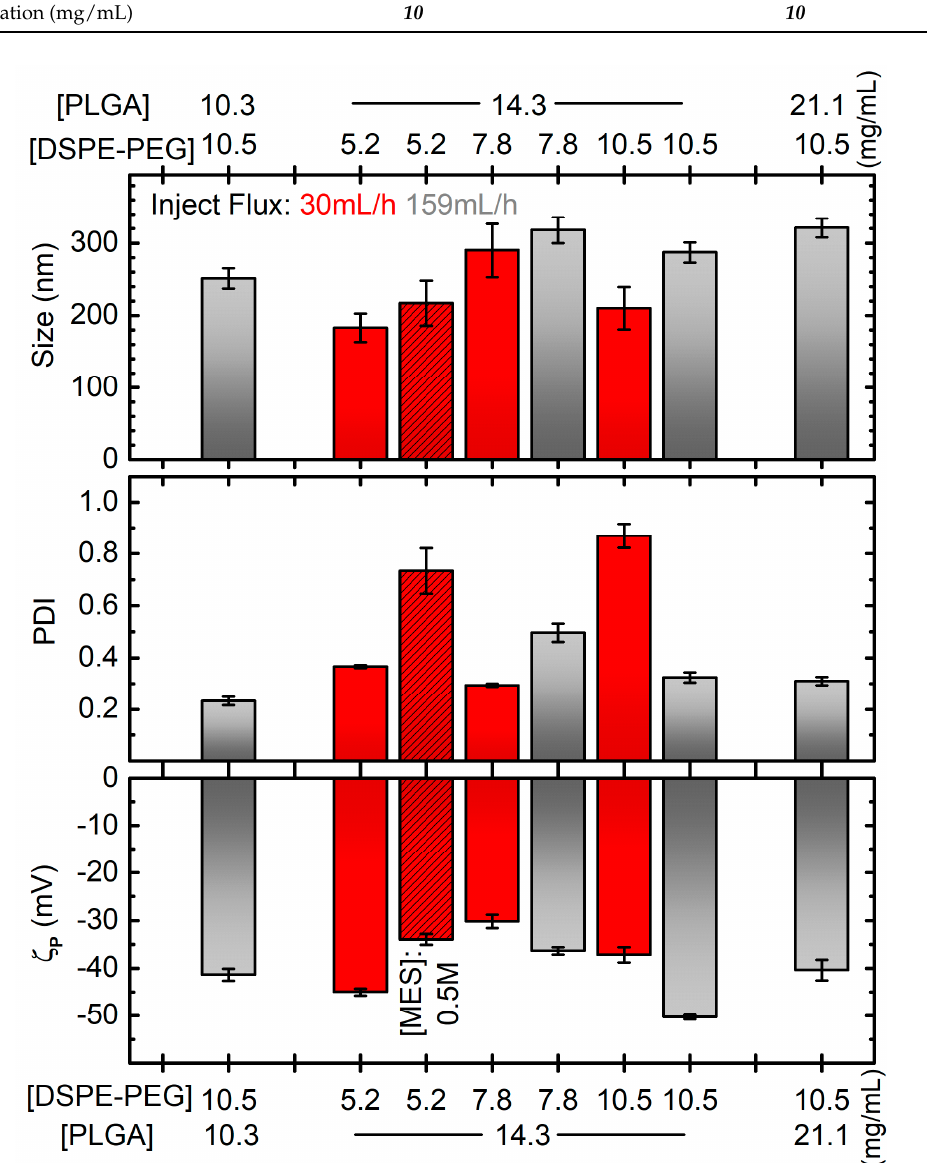
Figure 2. Diameter ( top ), PDI ( middle ) and zeta potential ( ζ p , bottom ) of PGZ-NPs developed by single emulsification-solvent evaporation method as a function of DSPE-PEG and PLGA